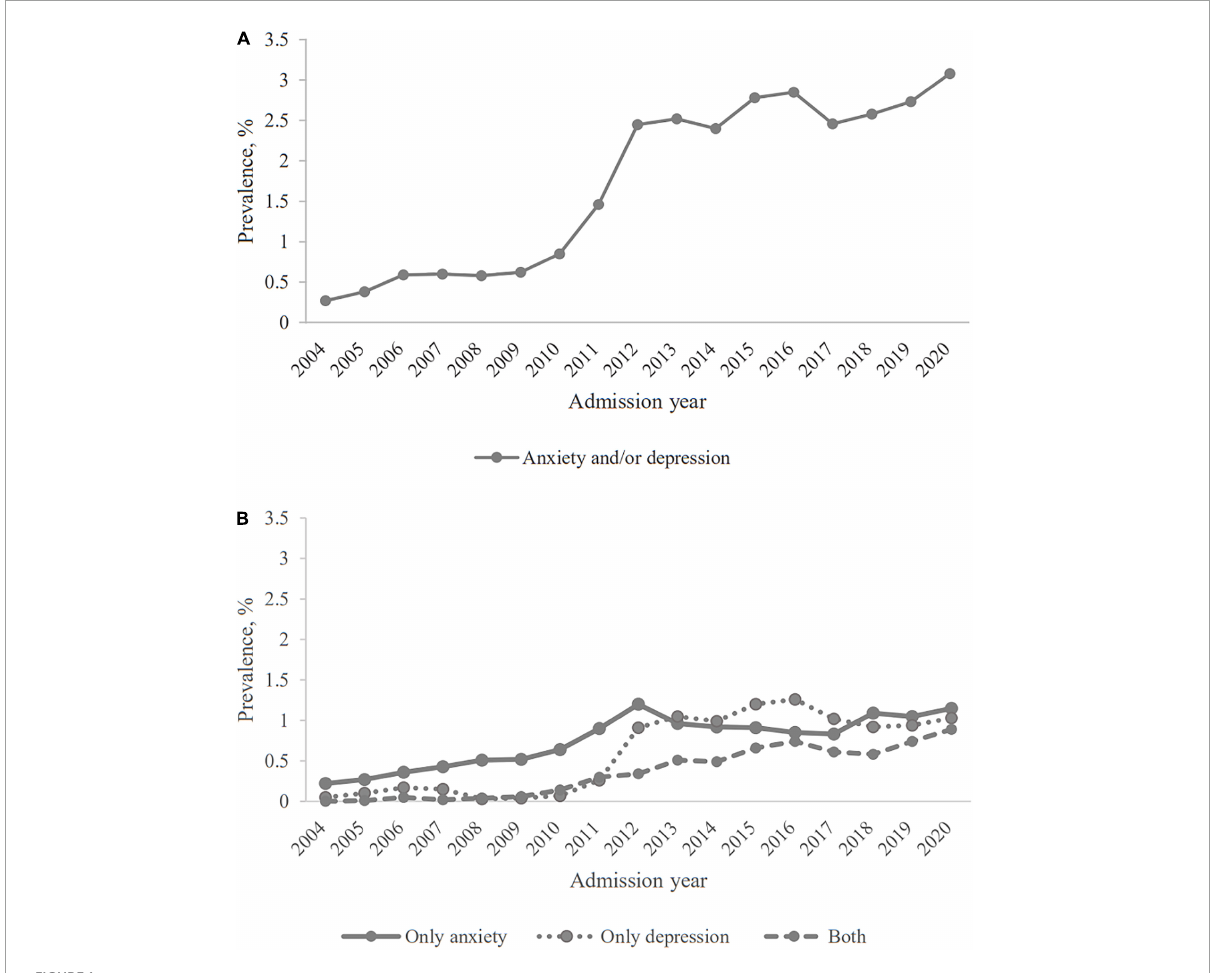
FIGURE1 The prevalence of anxiety and/or depression among patients hospitalized for AECOPD in Beijing. (A) Anxiety and/or depression; (B) three subtypes of anxiety and/or depression.